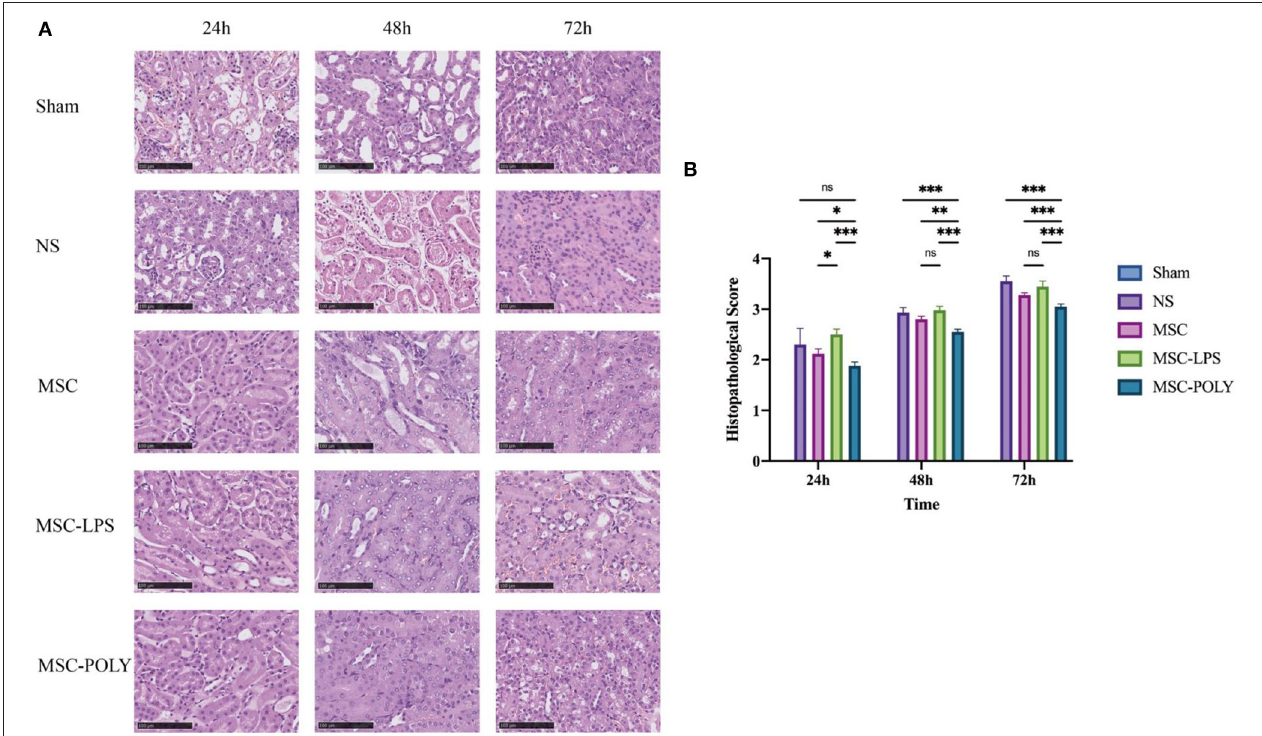
FIGURE 2 | Pathological sections and scores of kidneys in mice treated with different mesenchymal stem cell subsets. (A) Kidney H&E staining pictures (200 × ) of mice at three time points after sham operation (Sham), treatment with normal saline (NS), untreated mesenchymal stem cells (MSC), mesenchymal stem cells treated with 10 µ g/mL LPS (MSC-LPS), and mesenchymal stem cells treated with 1 mg/mL poly(I:C) (MSC-POLY), respectively. (B) Semi-quantitative histopathological scores at three time points of five groups. Values were expressed as mean ± standard deviation (mean ± SD), n = 6, ns = not statistically significant, * P < 0.05, ** P < 0.01, *** P <